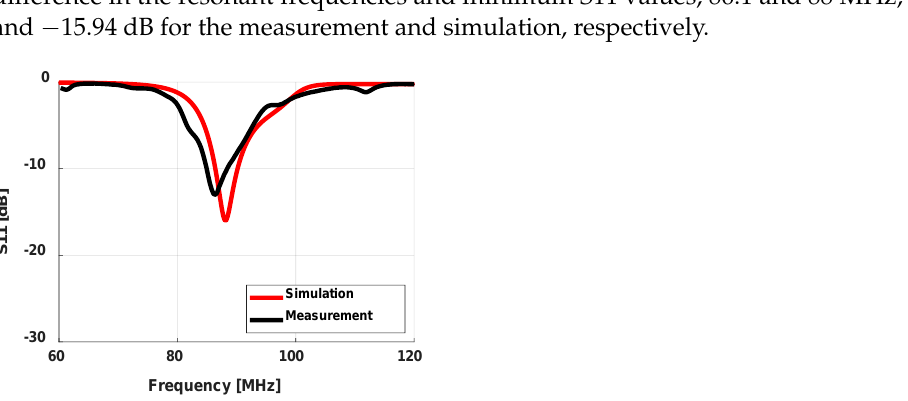
Figure 9. A picture of the fabricated QMSIW antenna prototype.